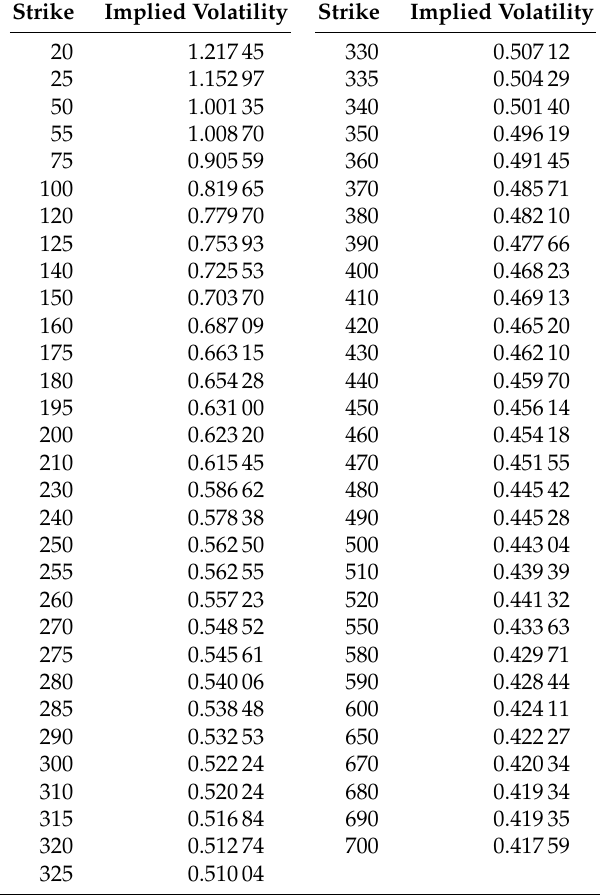
Table A1. Implied volatilities against strikes K for TSLA options expiring on 17 January 2020 as of 15 June 2018. This corresponds to a maturity T = 1.59178 and the forward is f =